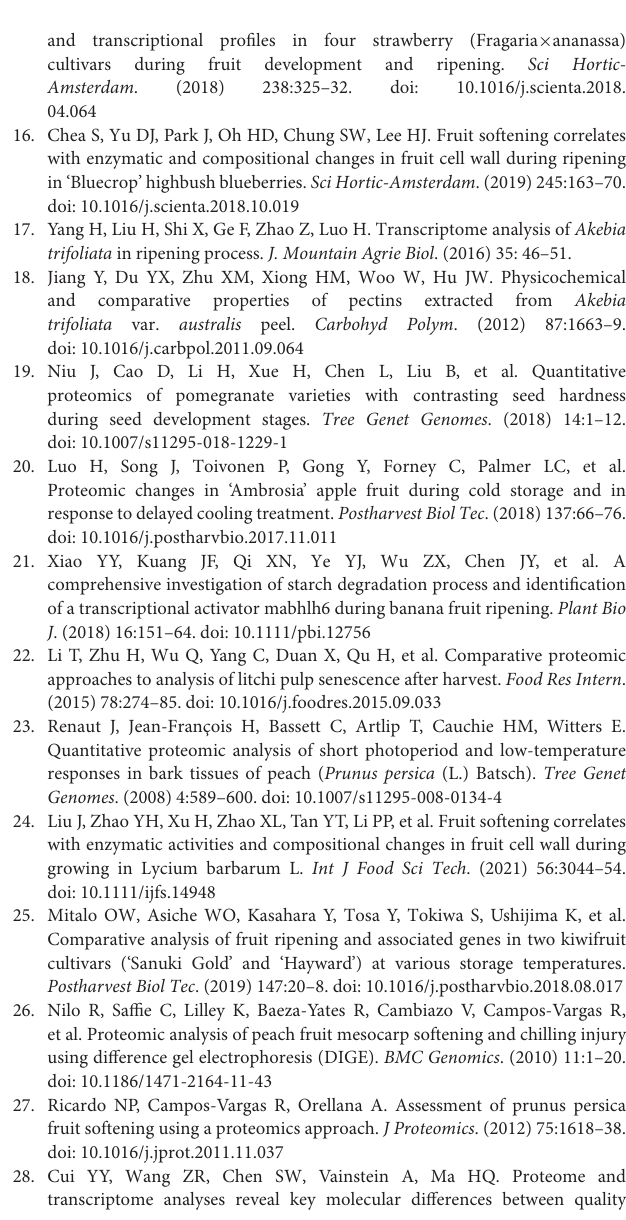
Supplementary Table 1 | Sequences of specific primers used for qRT-PCR experiments. Supplementary Table 2 | Summary of differentially accumulated